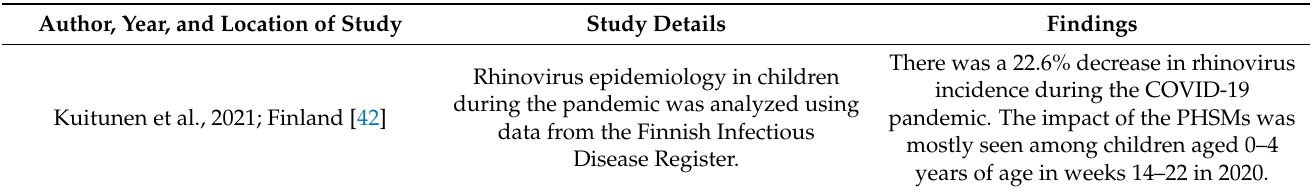
Table 4. Summary of rhinovirus-related articles included in the systematic literature